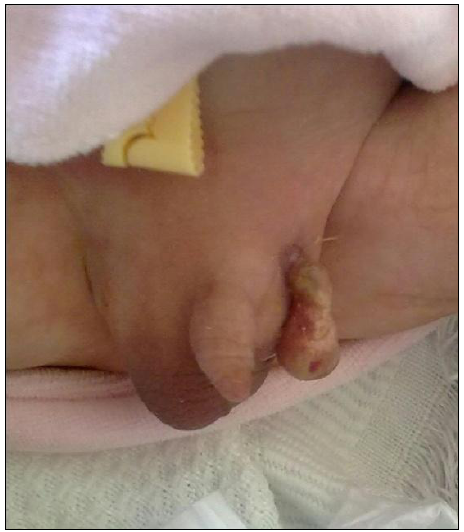
Figure 1: Testes lying outside the scrotum. During follow-up, the baby was thriving well, with left testicle palpable inside the